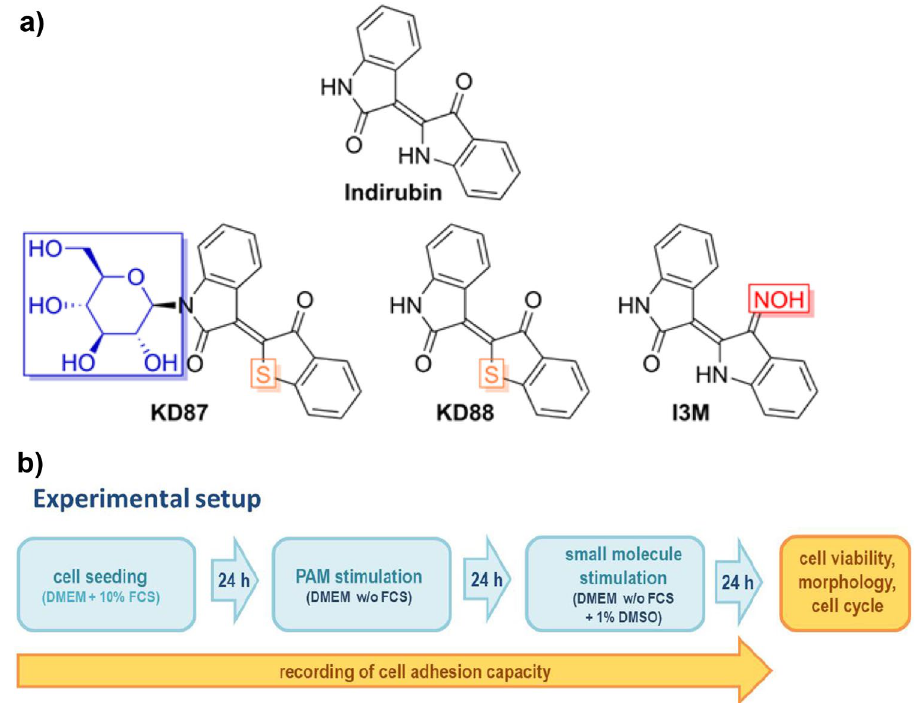
Figure 1. ( a ) Structural formulas of indirubin, thia-analogous indirubin derivatives KD87, KD88 and indirubin-3’-monoxime (I3M). Differences to indirubin are marked in color. ( b ) Overview of the experimental setup to analyse the combinatory effect of plasma treatment (PAM) and small molecule stimulation. All cells were allowed to adhere for 24 h. Cells were first treated with PAM and subsequently with the small